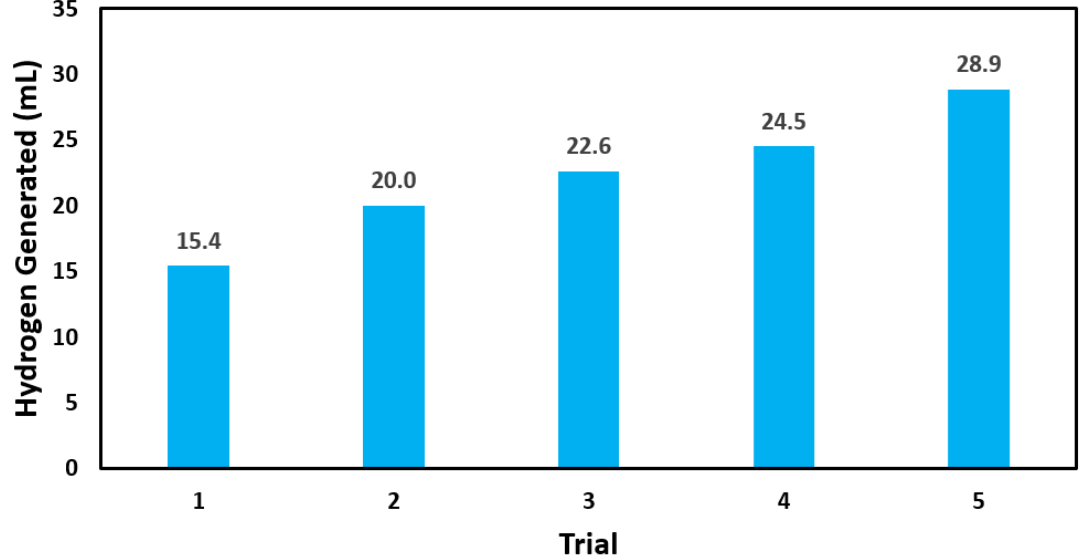
Figure 10. Catalytic reusability of BCD − AuNPs in the hydrolysis of sodium borohydride. Each trial ran for approximately 2 h under ambient conditions.